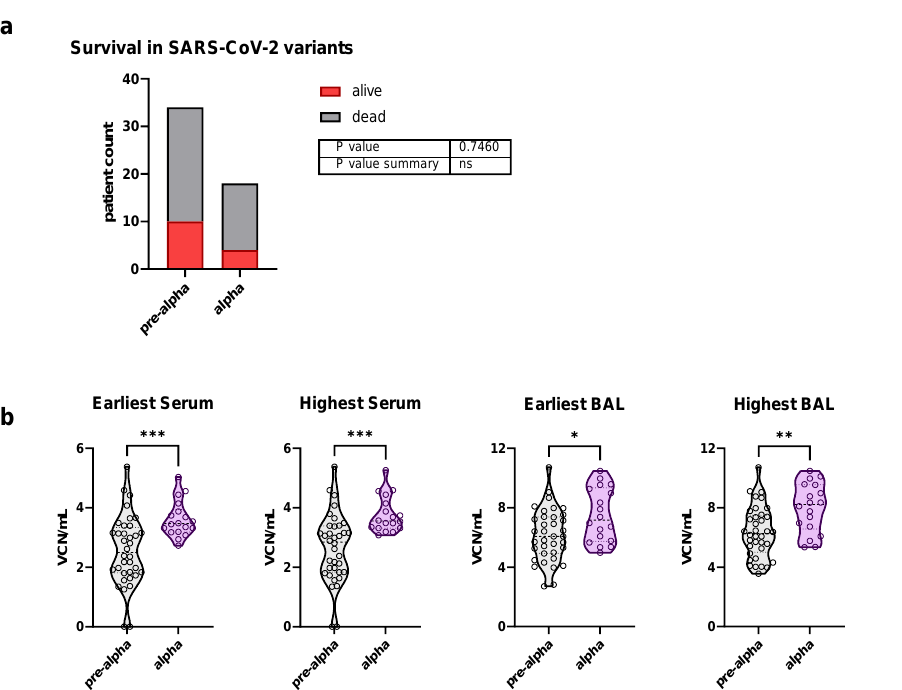
Figure 3. SARS-CoV-2 viral load of pre-alpha and alpha infected patients. SARS-CoV-2 variants in patient samples were identified by RT-qPCR. A Fisher’s exact test was performed to compare the outcome based on infections by SARS-CoV-2 pre-alpha and alpha VoC ( a ). A pooled analysis including all samples was performed according to SARS-CoV-2 pre alpha and alpha infection. Analysis of samples with the earliest and highest viral load per patient in serum and BAL samples is shown ( b ). Violin plot graphs showing medians (dashed lines) and quartiles (dotted lines) of SARS-CoV-2 copy numbers, as well as individual data points (circles) was used. Two patients from the second wave were excluded based on inconclusive variant detection. * = p < 0.05; ** = p < 0.01; *** = p < 0.001.